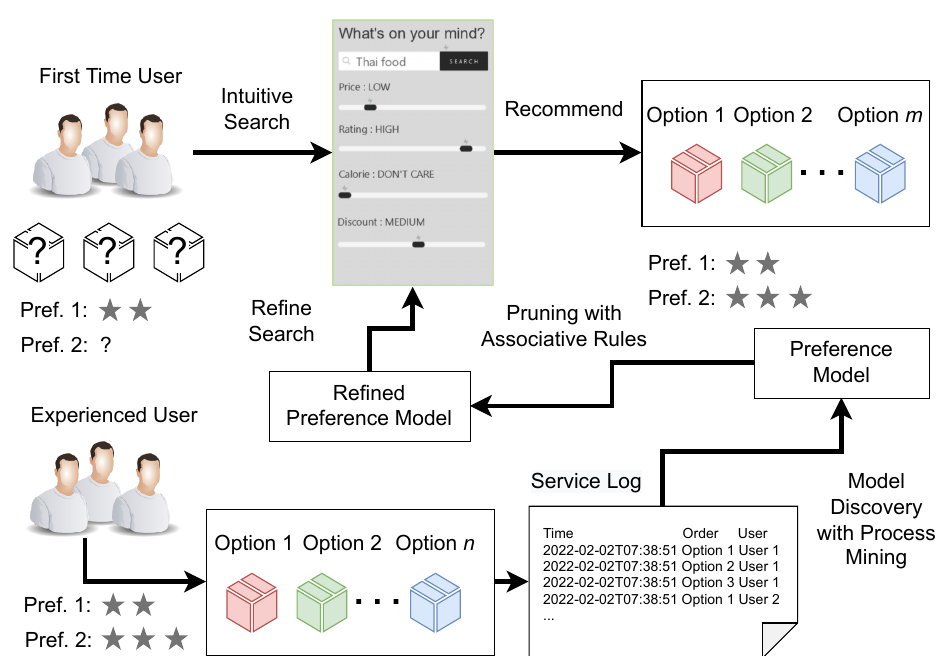
Figure 1. An overview of our proposed